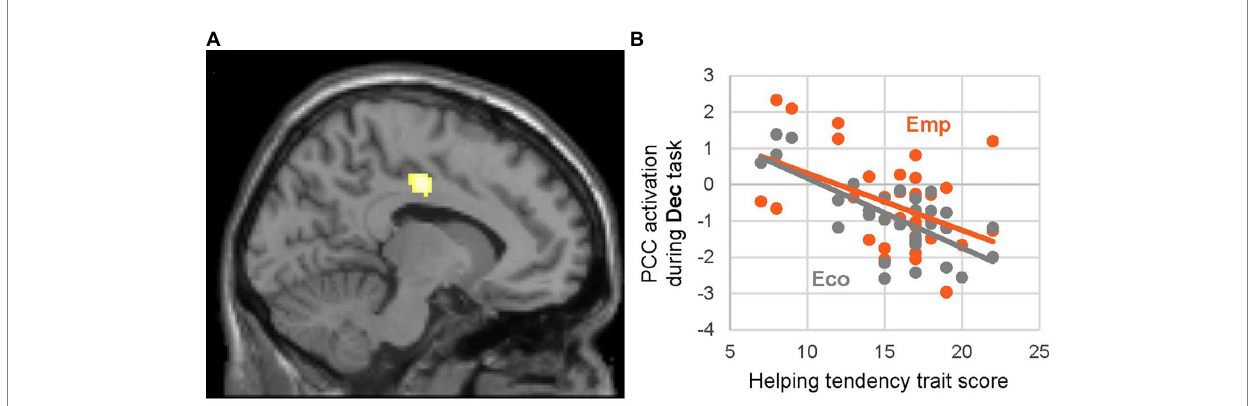
FIGURE 4 Effect of helping-tendency trait during helping decision (EmpDec + EcoDec). Significant negative effect of helping-tendency trait on activation during the thinking period on helping-decision context irrespective of the scenario type (EmpDec_think + EcoDec_think) is presented on the parasagittal section ( x = − 10) (A) . The scatter plot for estimated PCC [ − 10, − 14, 40] activation during Dec_think period (i.e., vs. baseline) against the helping- tendency trait score and regression line are given separately for Emp (orange) and Eco (gray) scenarios (B) . Other details are the same as for Figure